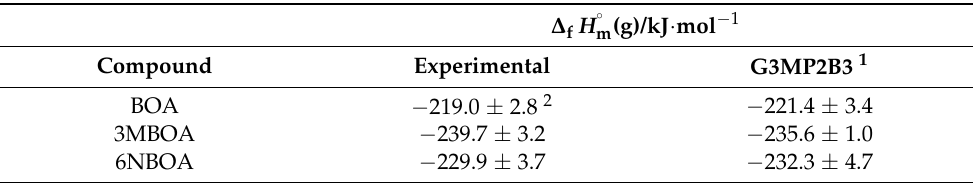
Table 4. Experimental and G3MP2B3-computed gas-phase enthalpies of formation of the benzoxa- zolones studied, at T = 298.15